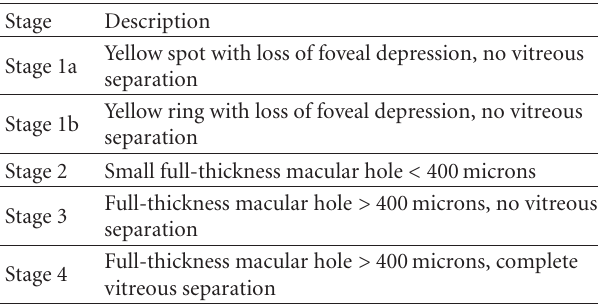
Table 1: Modified Gass classification system of macular holes.